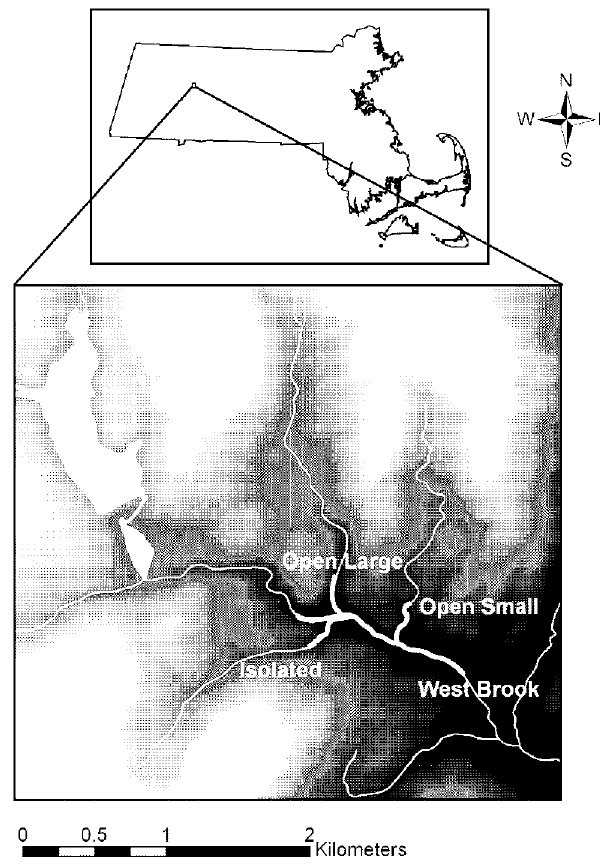
Figure 5. Map of the study area watershed in western Massachusetts, USA. Study area indicated by bold white